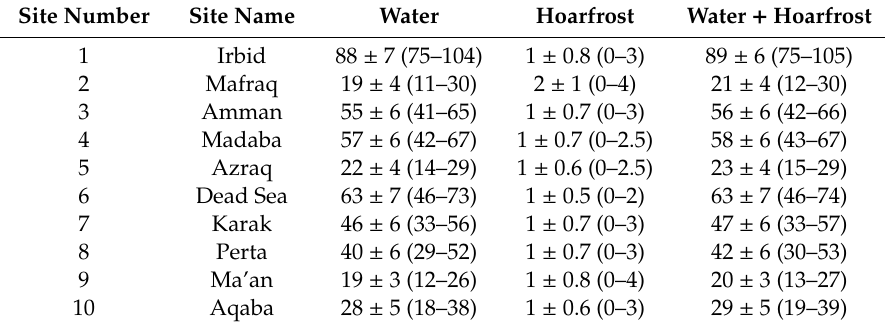
Table 2. Overall mean ± standard deviation as well as the range of the yearly cumulative dew yield. The values are listed as mean ± Std (min–max) in mm.